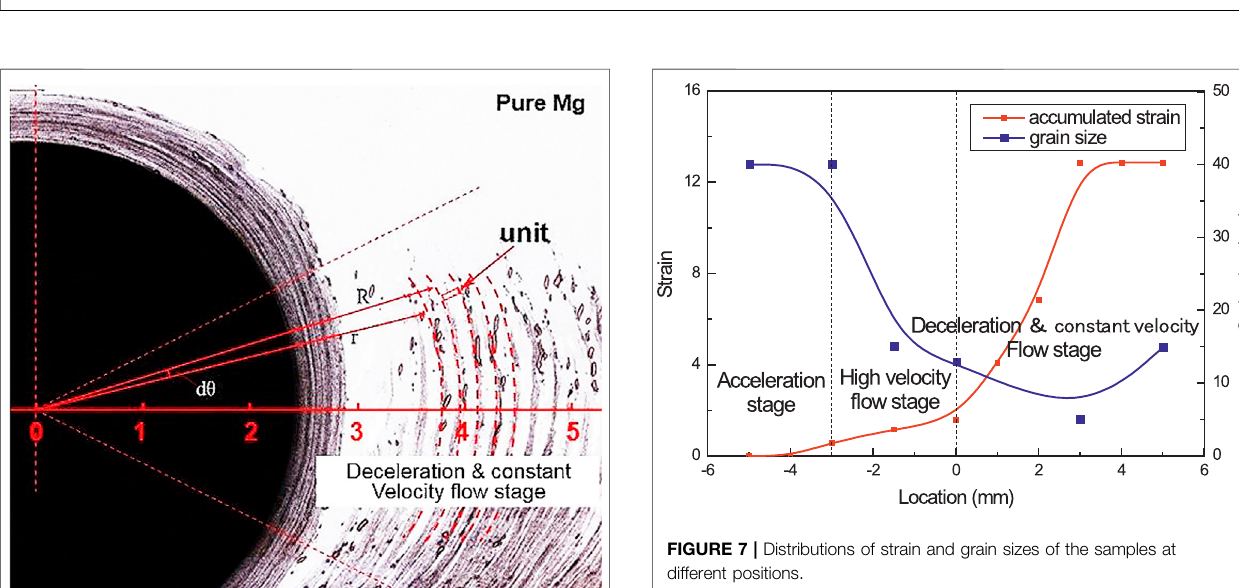
FIGURE 5 | High velocity fl ow stage and approximate deformation model.